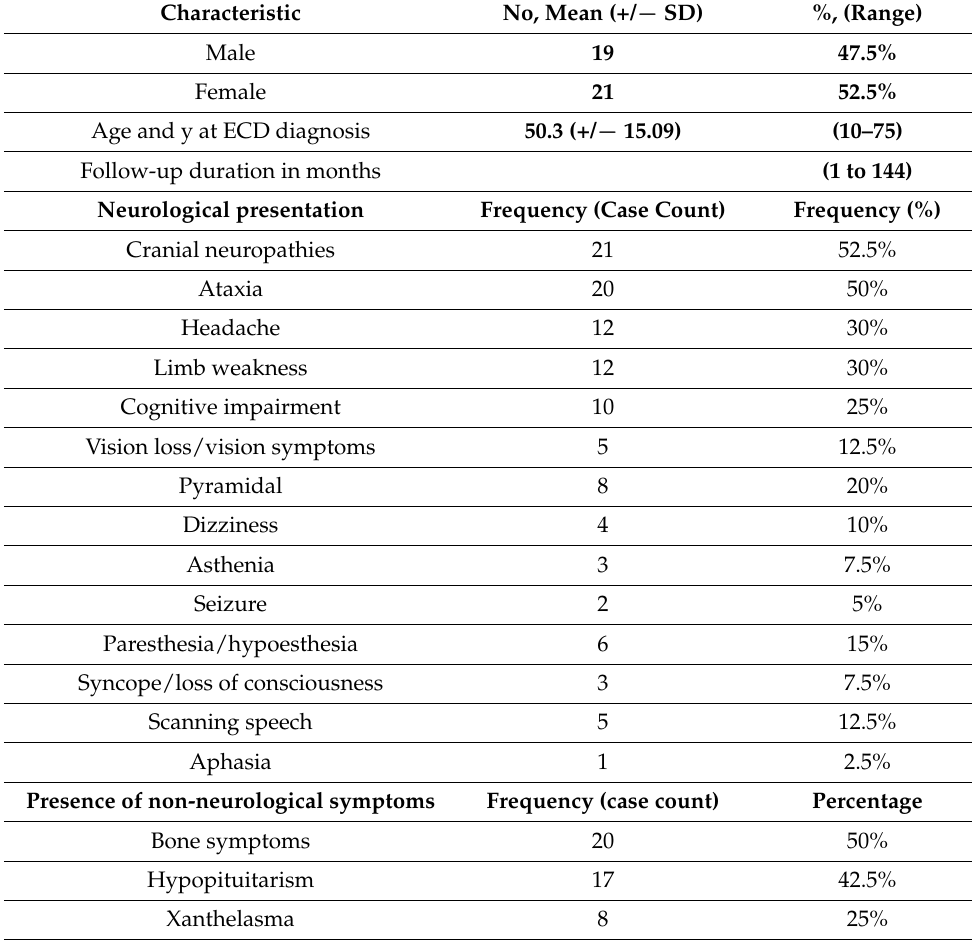
Table 1. The characteristics of ECD patients who presented with neurological